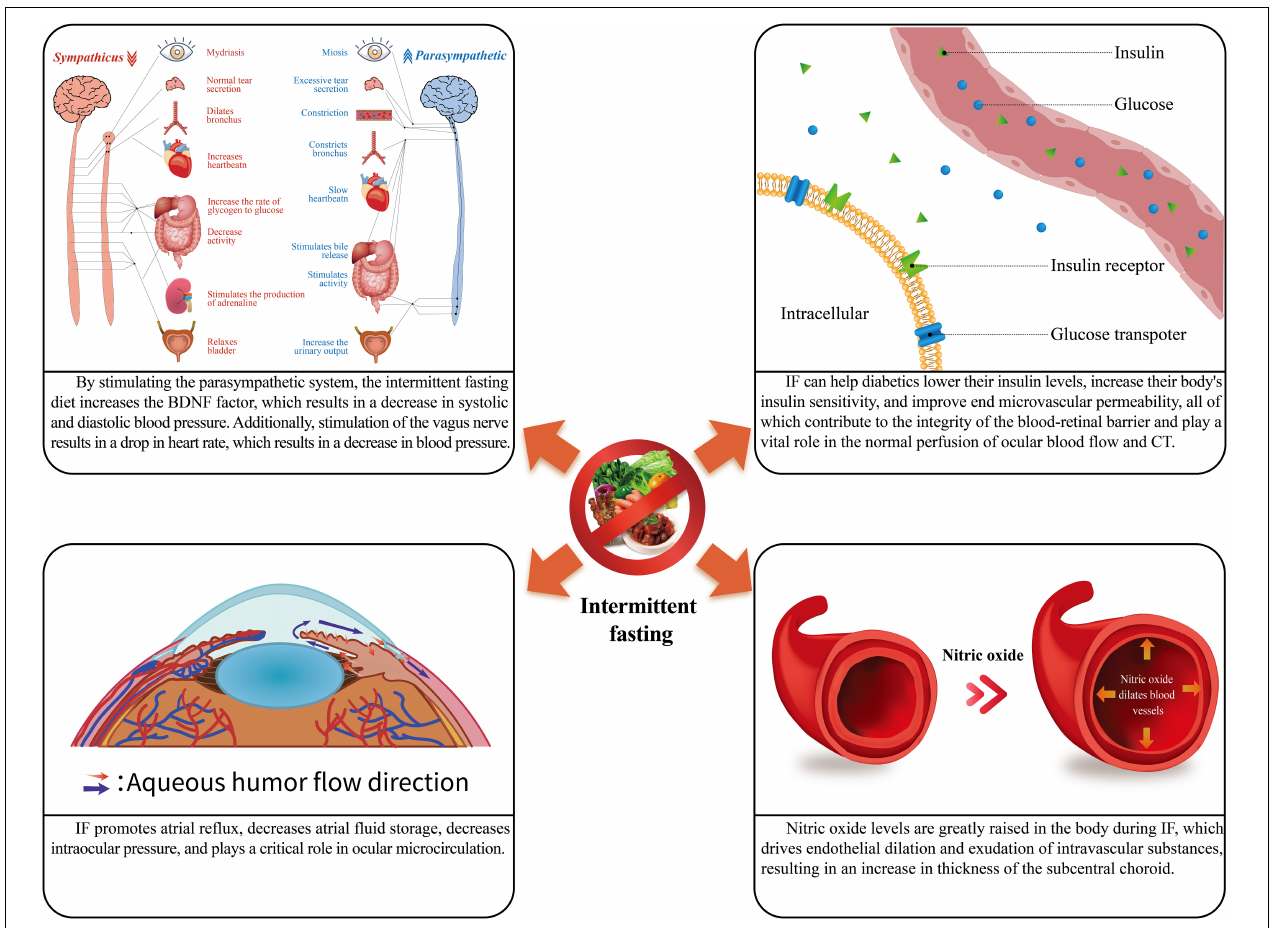
FIGURE 1 | The physiological role of intermittent fasting. IF, intermittent fasting; CT, choroidal